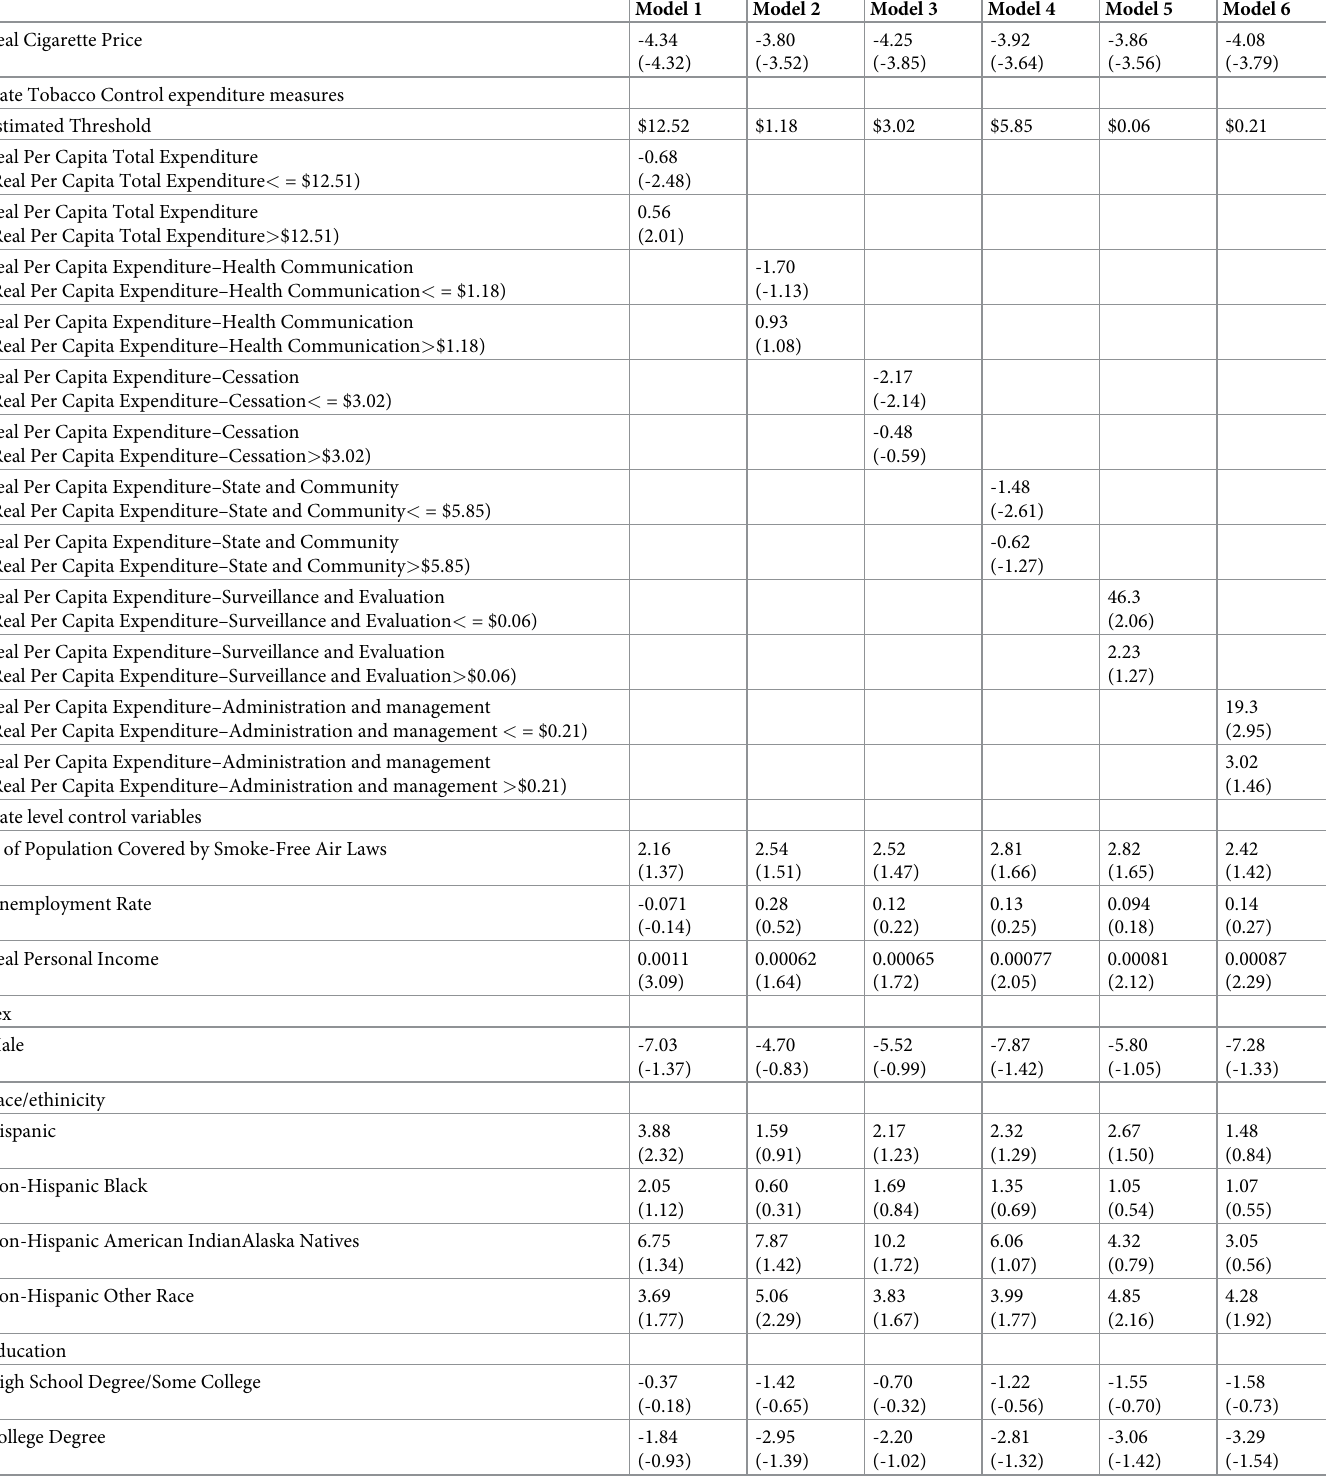
Table 4. Impacts of state tobacco control expenditures by Best Practice category on per capita cigarette sales: United States for years 2008–2012 fixed effects panel threshold